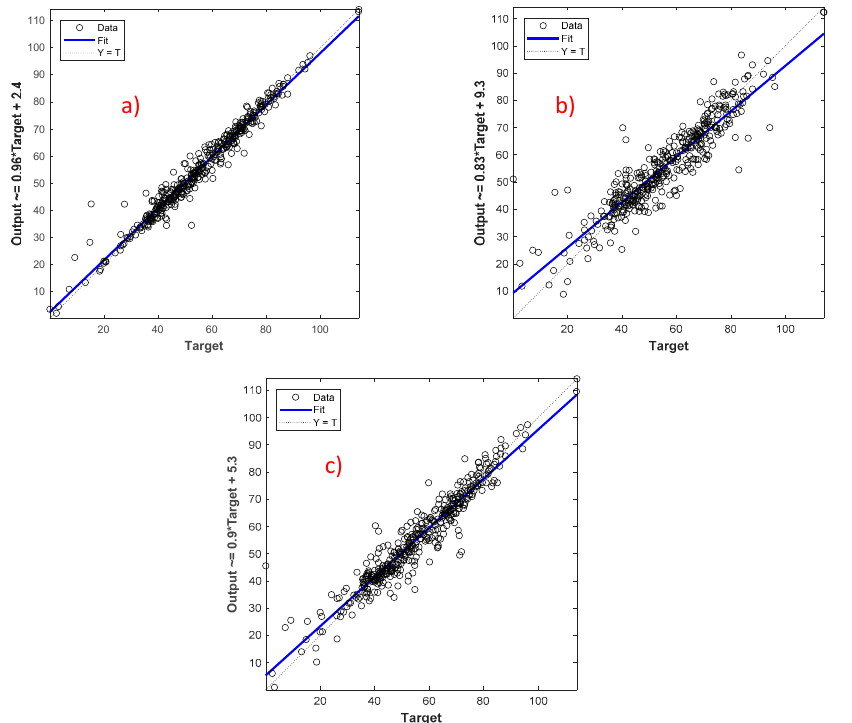
Figure 7. Relation between the original power output and the predicted power output in training and validation: ( a ) With all features; ( b ) CFS feature selection technique; ( c ) ReliefF feature selection technique.